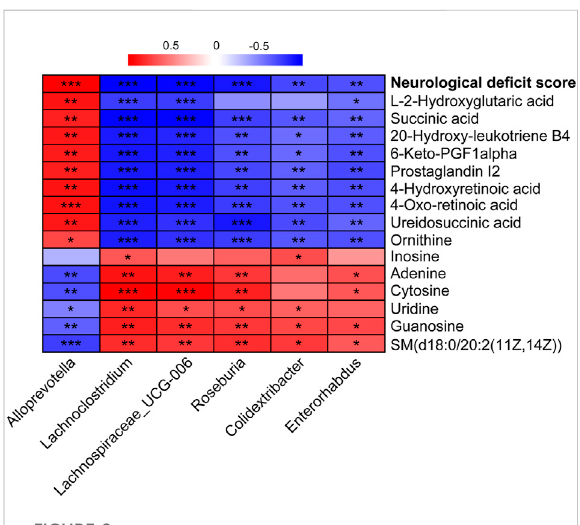
FIGURE 8 The correlation between the altered genera and metabolites and between the altered genera and neurological de fi cit score. Correlations were obtained using Spearman test. Red represents positive correlation; blue represents negative correlation. * p < 0.05, ** p < 0.01, *** p <